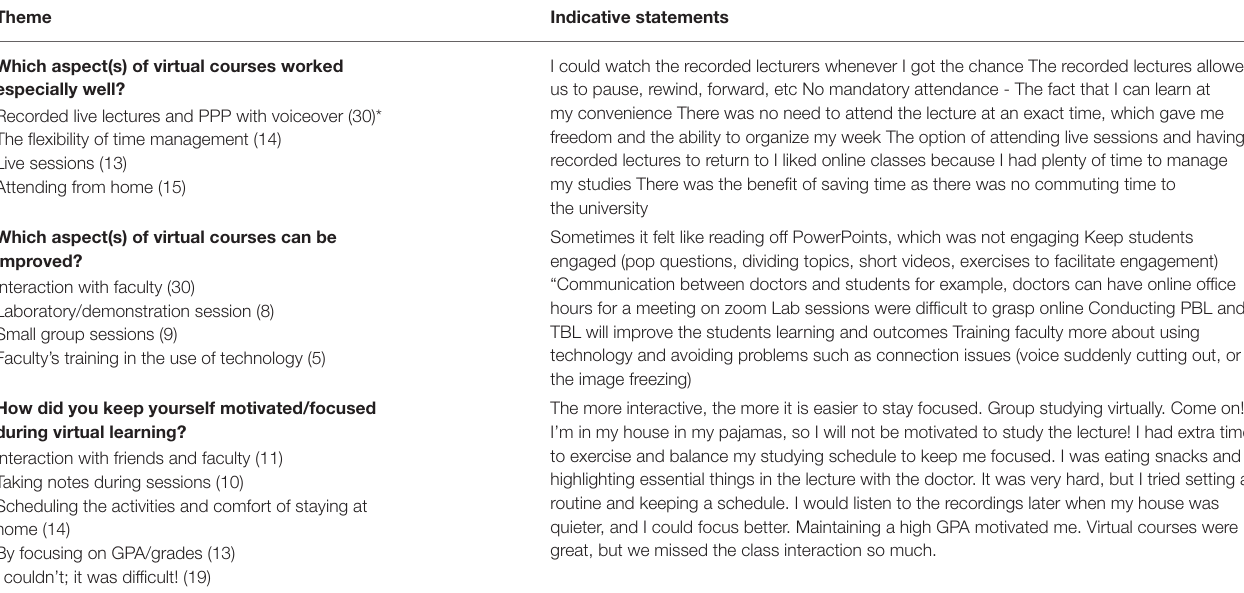
TABLE 4 | Open c-text comments are arranged as common themes along with representative statements.